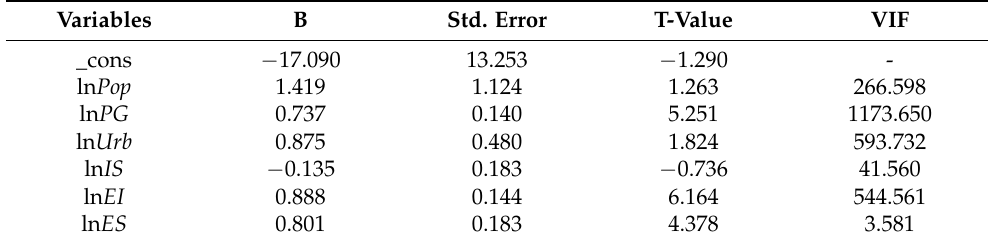
Table 3. Multicollinearity results.